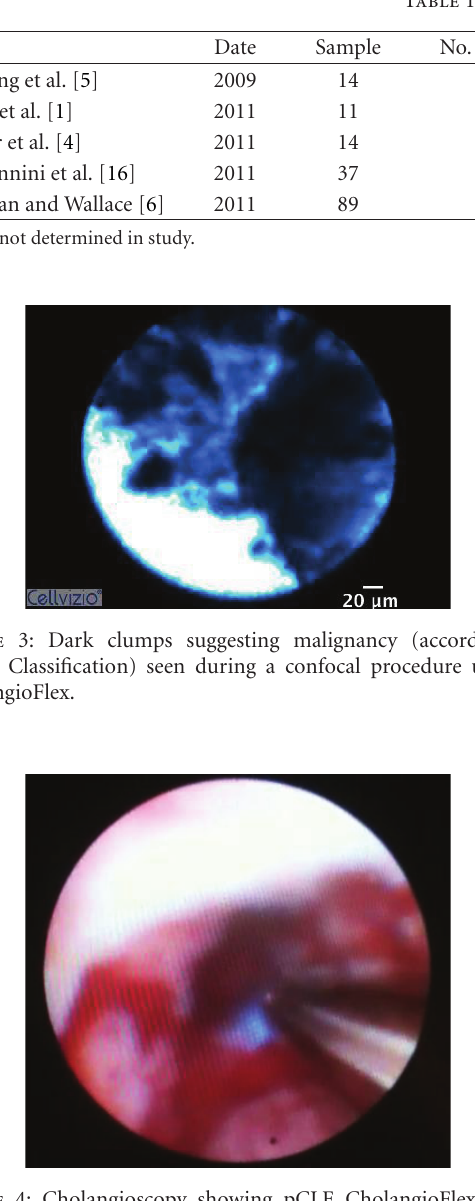
Figure 4: Cholangioscopy showing pCLE CholangioFlex probe being inserted into a bile